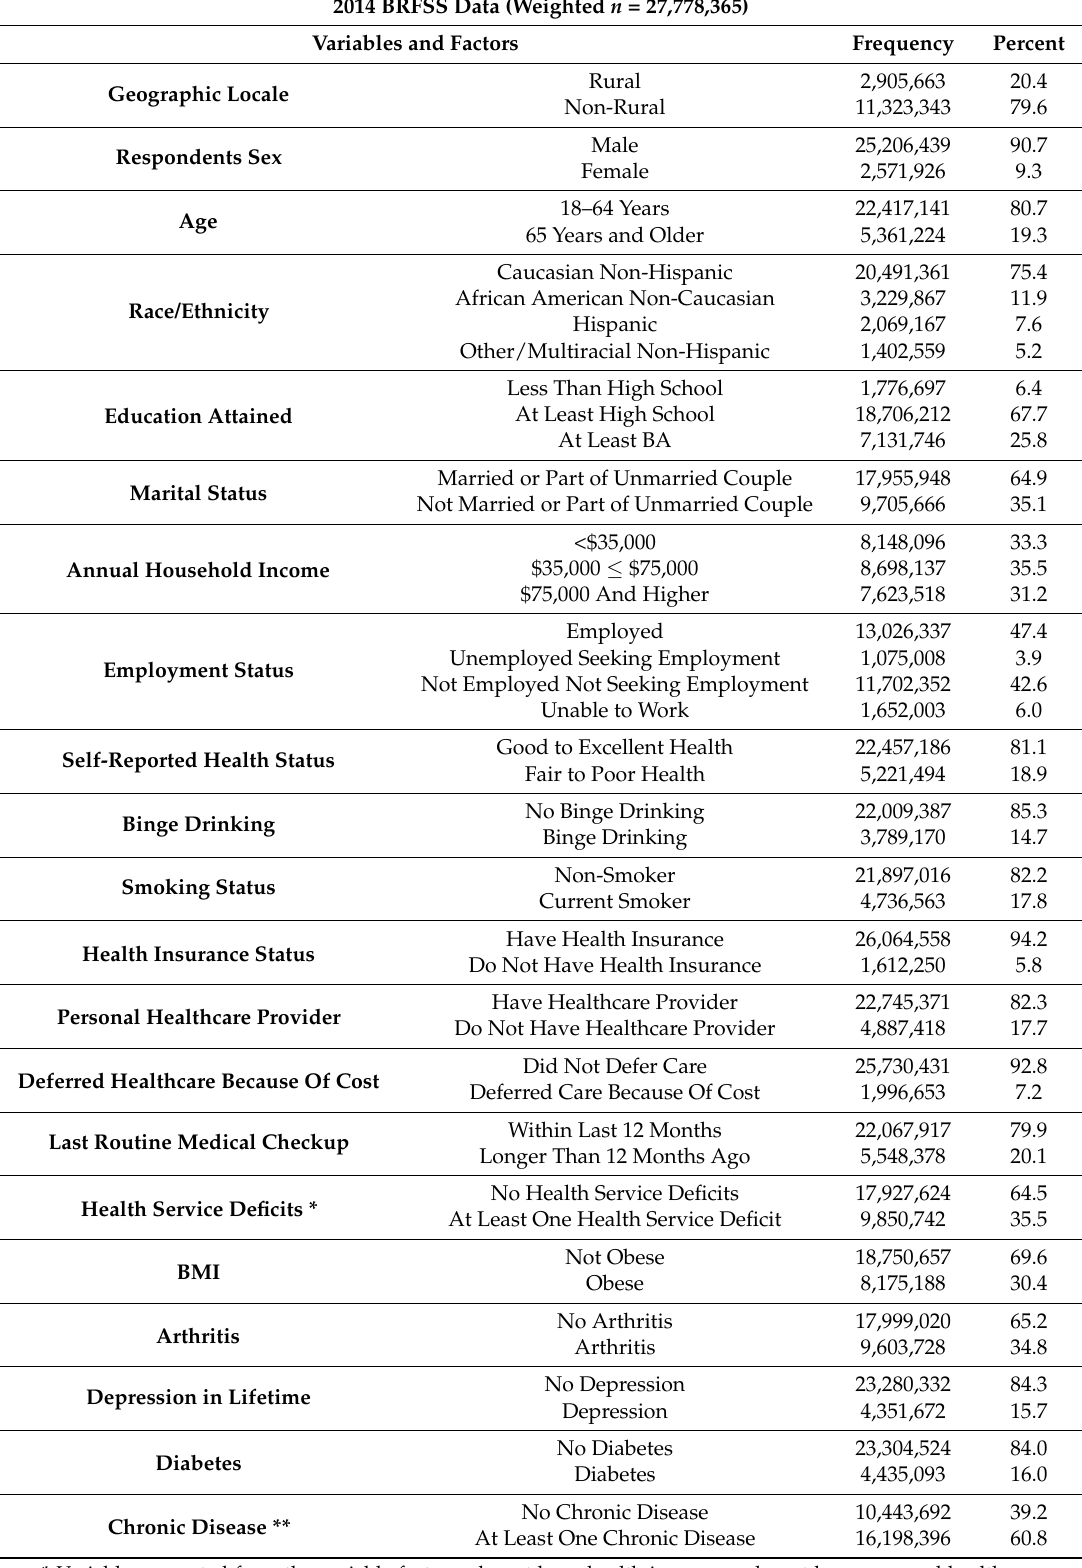
Table 1. Description of US